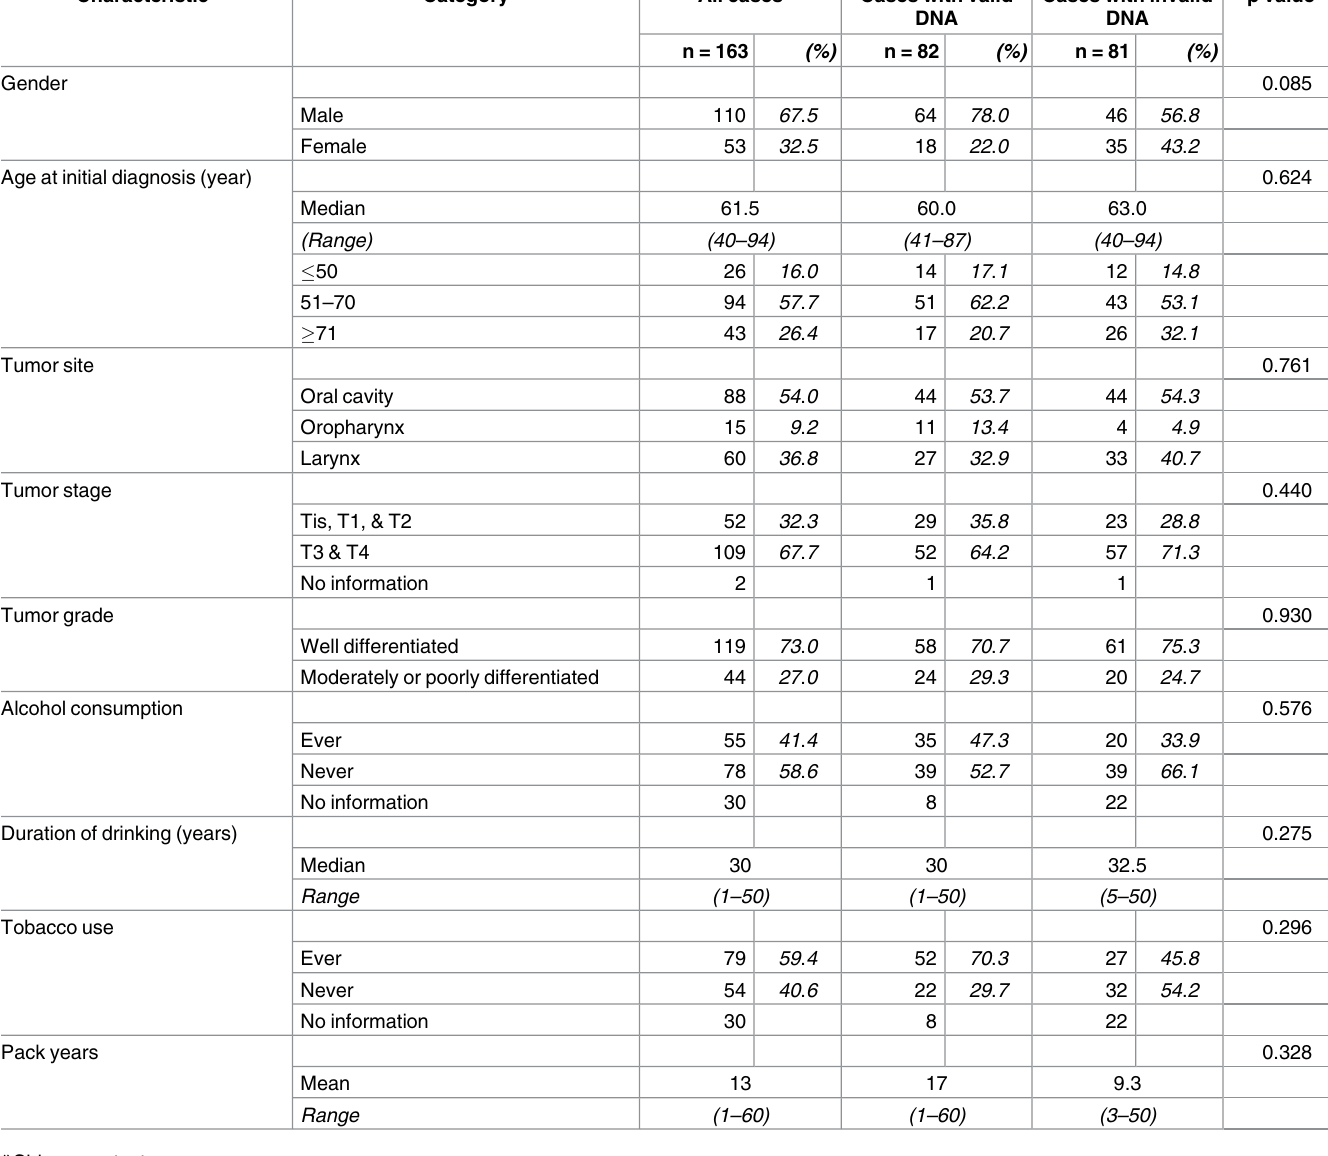
Table 1. Clinical and epidemiologic risk profile of the